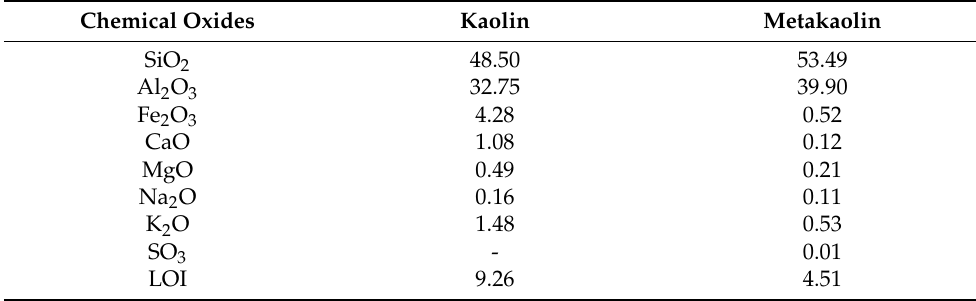
Table 2. Chemical composition test on kaolin and metakaolin samples.